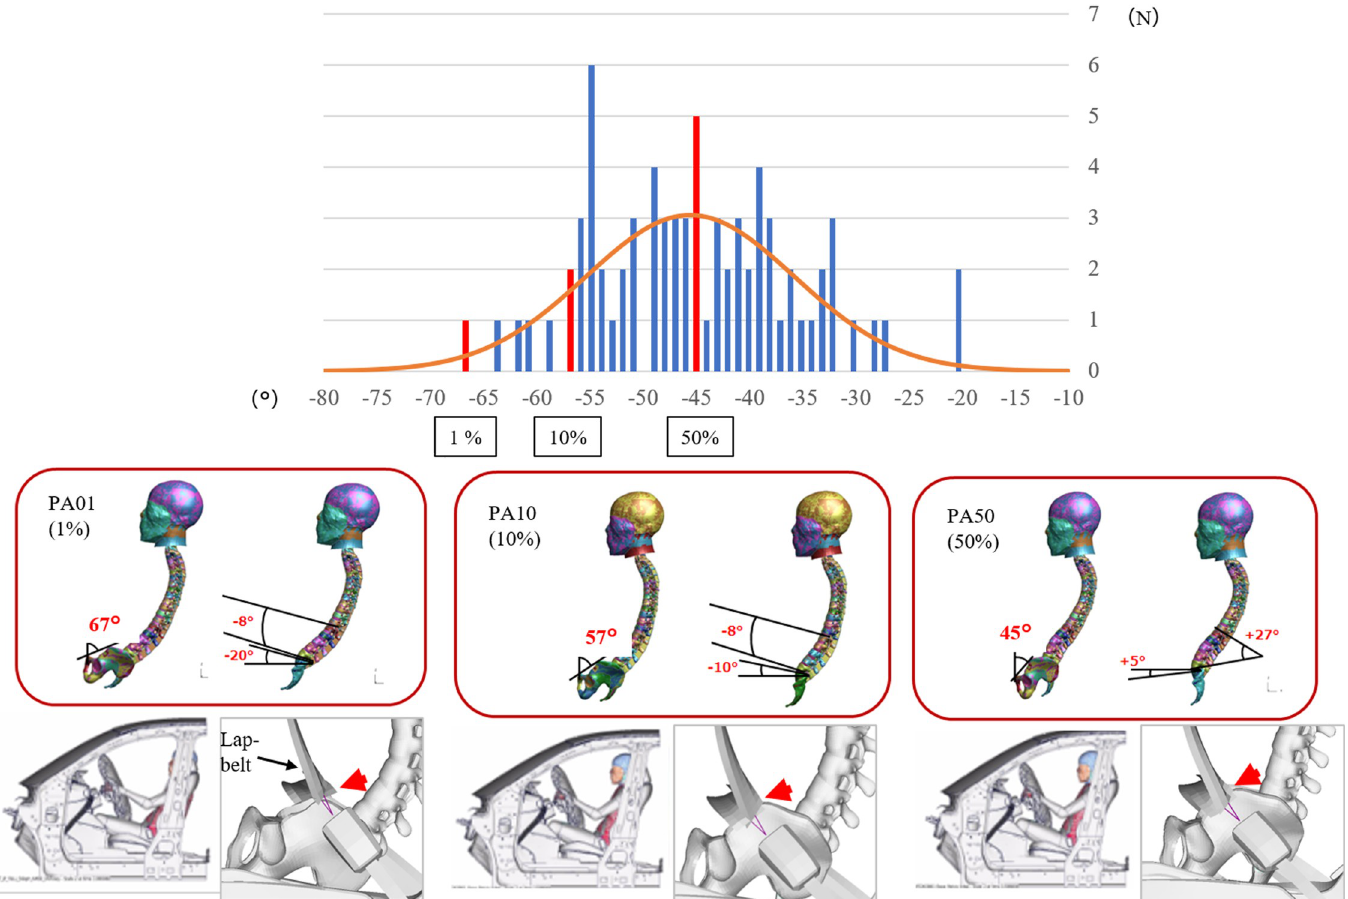
Fig 3. Normal distribution and histogram of PA (upper figure). Angle correction model of each model (middle figure). PA01; PA 67˚, LL -8˚, SS -20˚. PA10; PA 57˚, LL -8˚, SS -10˚. PA50; PA 45˚, LL 27˚, SS 5˚. Diagram of the seat of each model and the position of the lap-belt